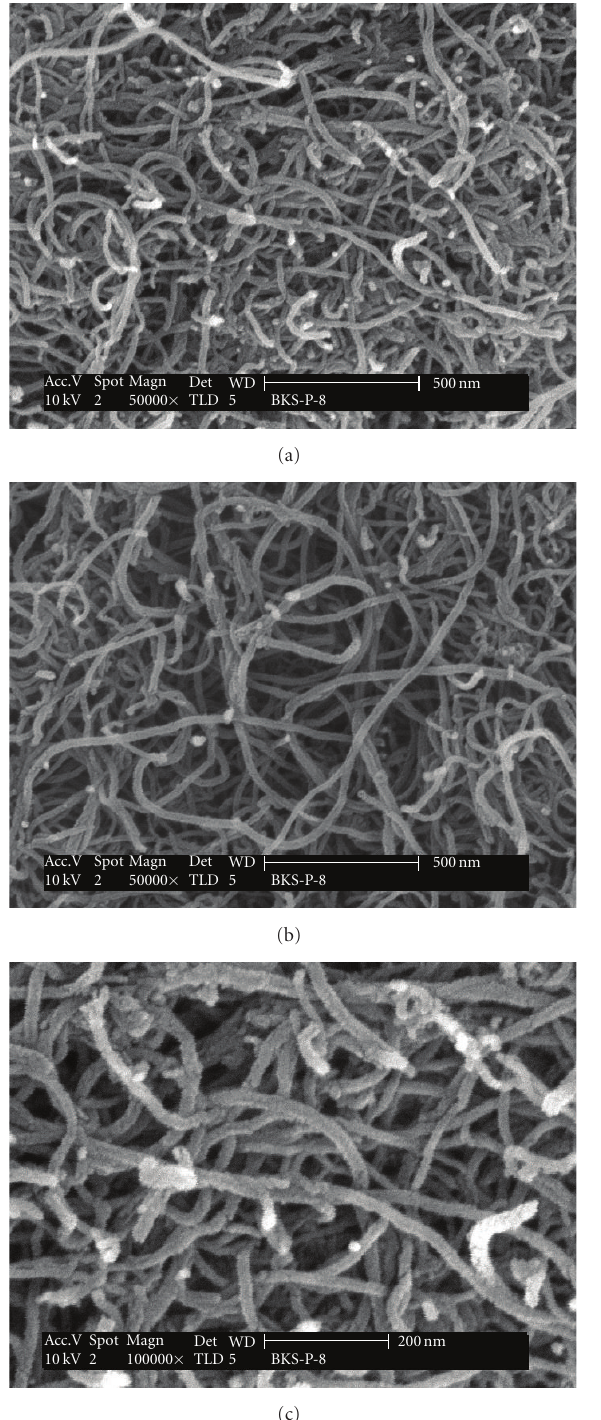
Figure 5: Representative TEM micrographs for CNTs grown with (a) 50% Co, (b) 25% Co + 25% Ni, and (c) 50% Ni on MgO